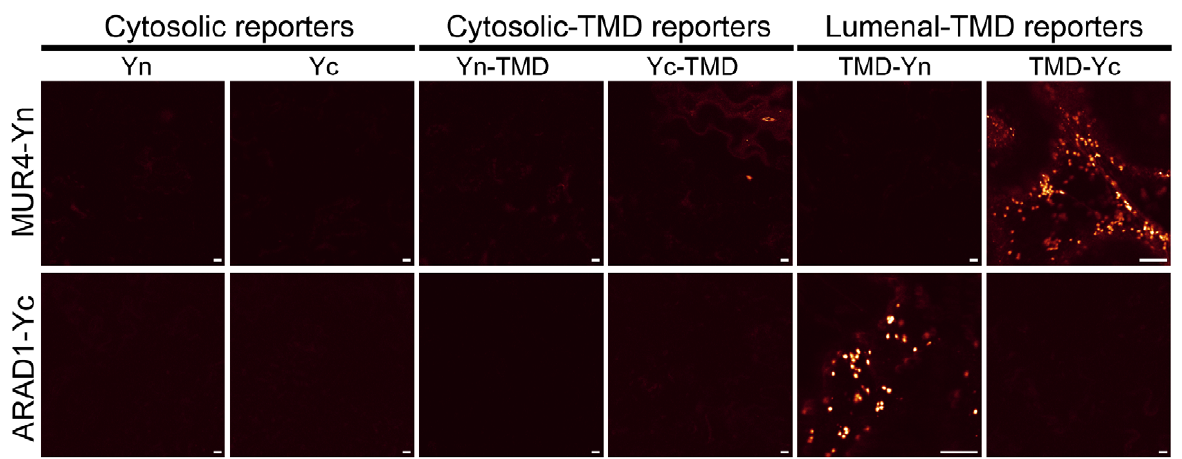
Figure 8. GO-PROMTO analysis of ARAD1 and MUR4, putative arabinosyltransferase and UDP-xylose/arabinose epimerase. ARAD1 and MUR4 fused with the Yc and Yn tags, respectively, at the C-termini were transiently expressed in Nicotiana benthamiana . Fluorescence complementation with lumenal reporters suggests Golgi-lumenal localization of ARAD1 and MUR4 C-termini. Observation was carried out by CLSM at 3 DPI. Scale bars, 10 m m. At least two individual experiments were performed for each combination with the similar results. Raw images are shown.